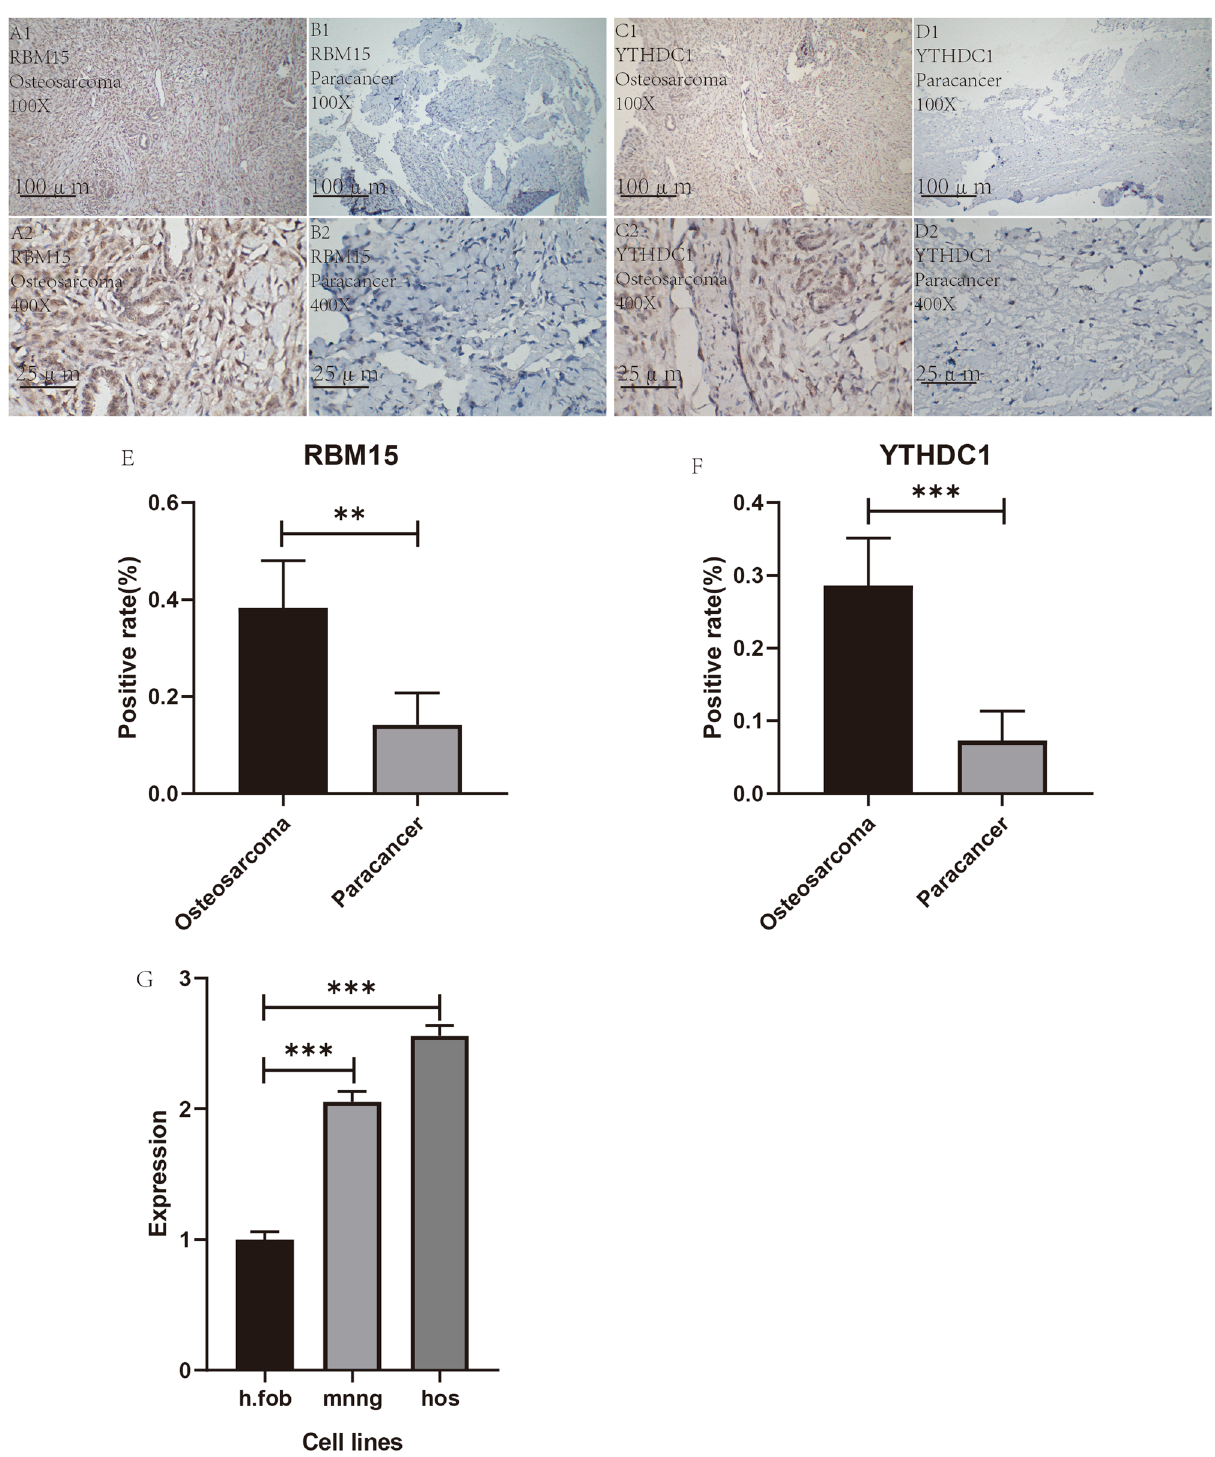
Figure 11. Immunohistochemical analysis and statistical analysis of positive rate. ( A1 – B2 ) Show the specific expression of RBM15 in osteosarcoma and in paraneoplastic tissues. ( C1 – D2 ) Show the difference of YTHDC1 expression in osteosarcoma and in paraneoplastic tissues. ( E , F ) Indicate the statistical plots of all positive immunohistochemical staining rates for RBM15, respectively. ( G ) Shows the expression of RBM15 in two osteosarcoma cell lines and one control cell line, "*" indicates P < 0.05, "**" indicates P < 0.01, "***" denotes P <